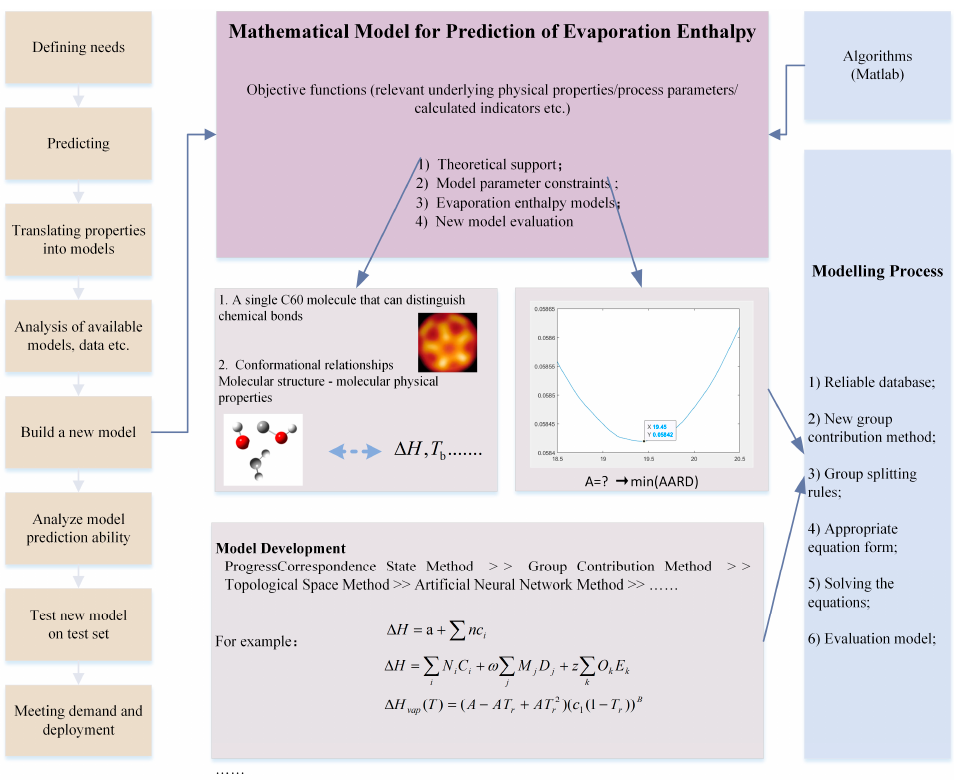
Figure 1. Design framework for a model to predict the enthalpy of evaporation.